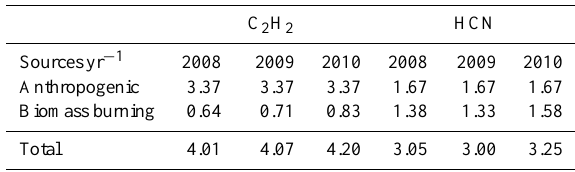
Table 2. Global C 2 H 2 and HCN emission sources (Tg(species)yr − 1 ) during the period 2008–2010 from the data set used in